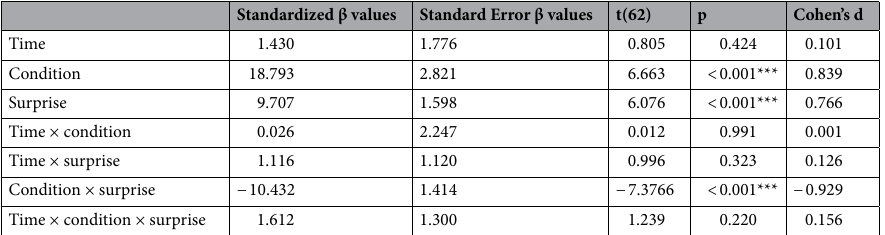
Table 2. Predictors of reaction time. Standardized beta values (β) are displayed for significant and non- significant predictors of reaction time.